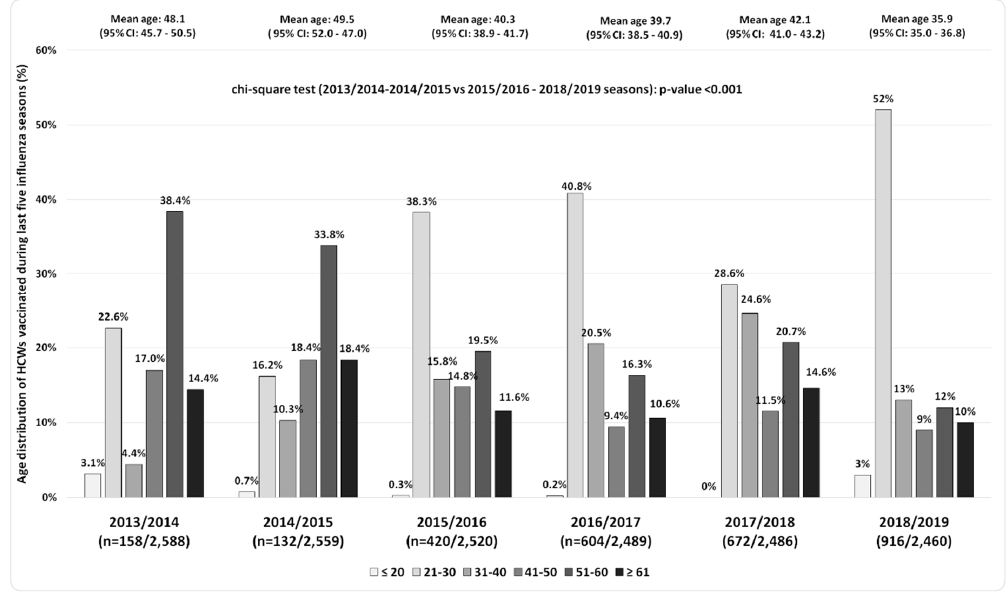
Figure 2. Age distribution of vaccinated HCWs during the last six influenza seasons at the University Hospital of Palermo (2013 / 2014–2018 /